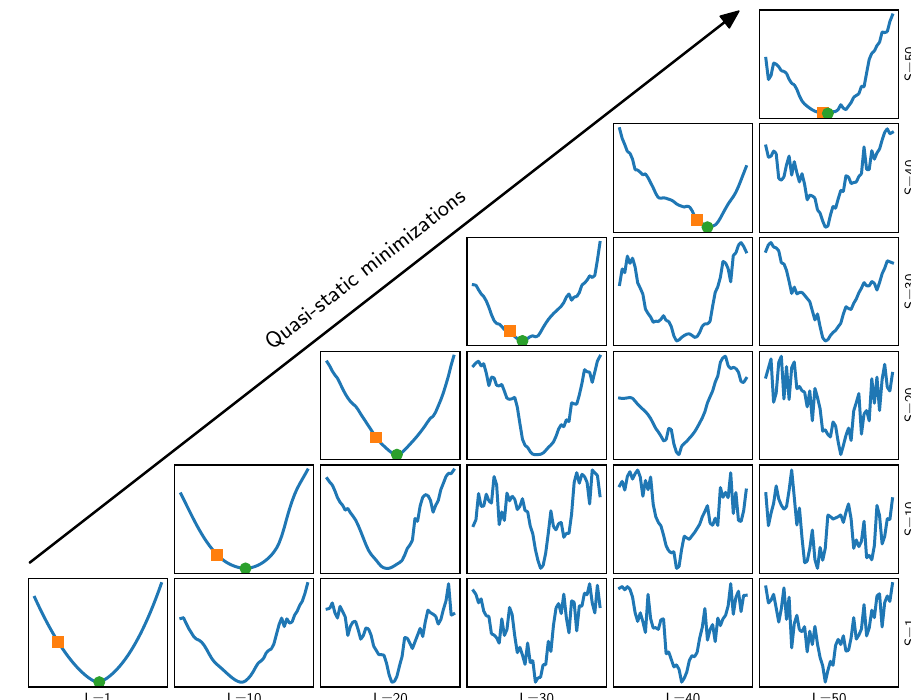
Figure 5. Cost functions of the IEnKS projected in one direction of the analyzed ensemble (hence centered and normalized) with various DAW parameters S , L . A quasi-static minimization can be visualized from these panels. It begins with the bottom-left cost function; the orange square is the starting point and the green dot is at the minimum. From the bottom-left cost function up to the top-right cost function, batches of 9 then 10 observation vectors are progressively added to the DAW, and the minimizer (green dot) is updated accordingly.